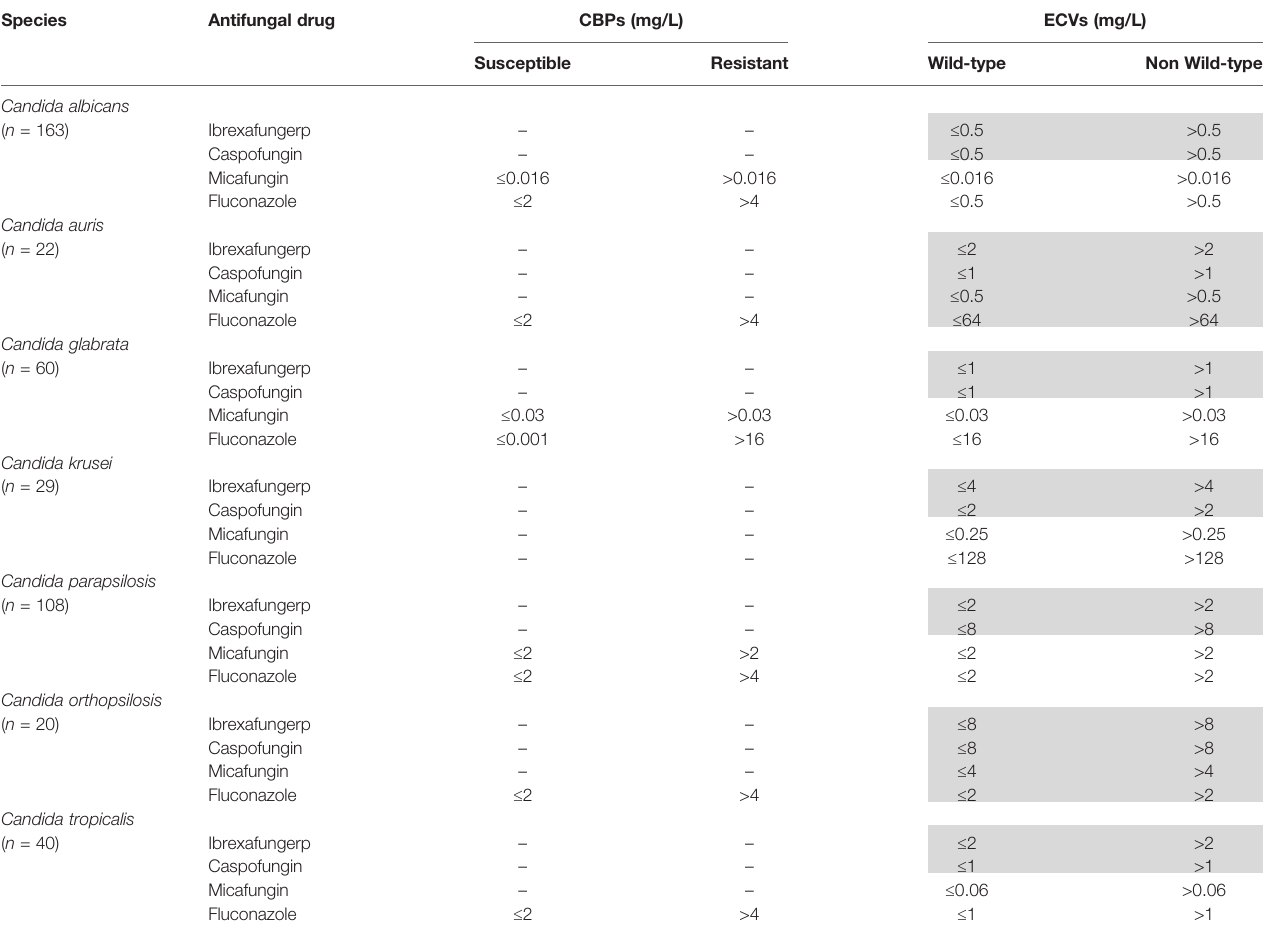
TABLE 1 | EUCAST clinical breakpoints (CBPs) and epidemiological cutoff values (ECVs).